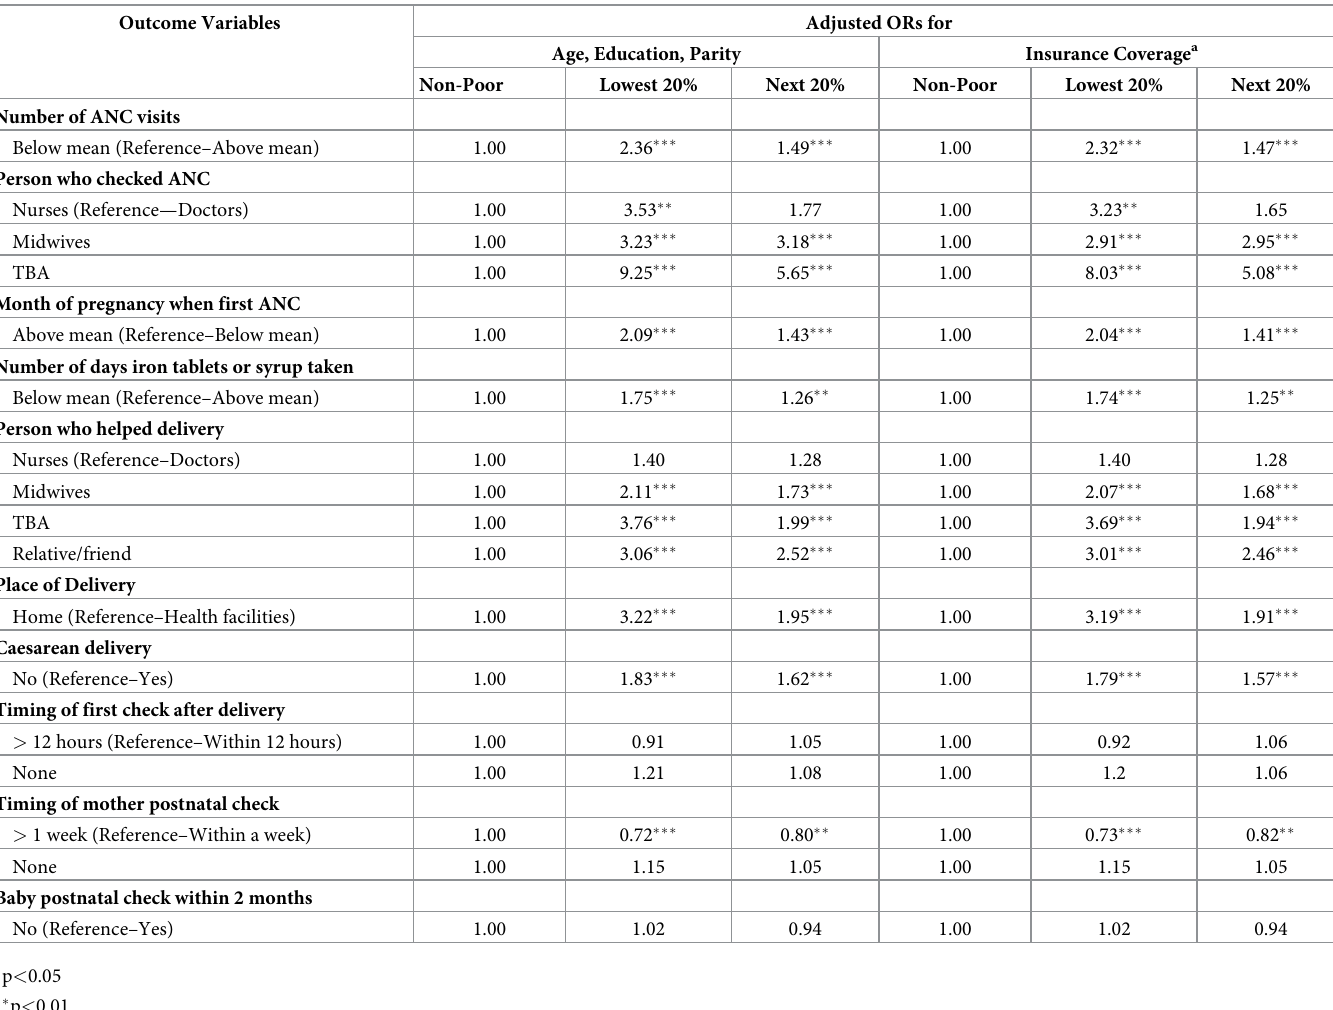
Table 4. Adjusted Odds-Ratios of maternal and child health services outcomes for Urban Poor vs. Non-Poor